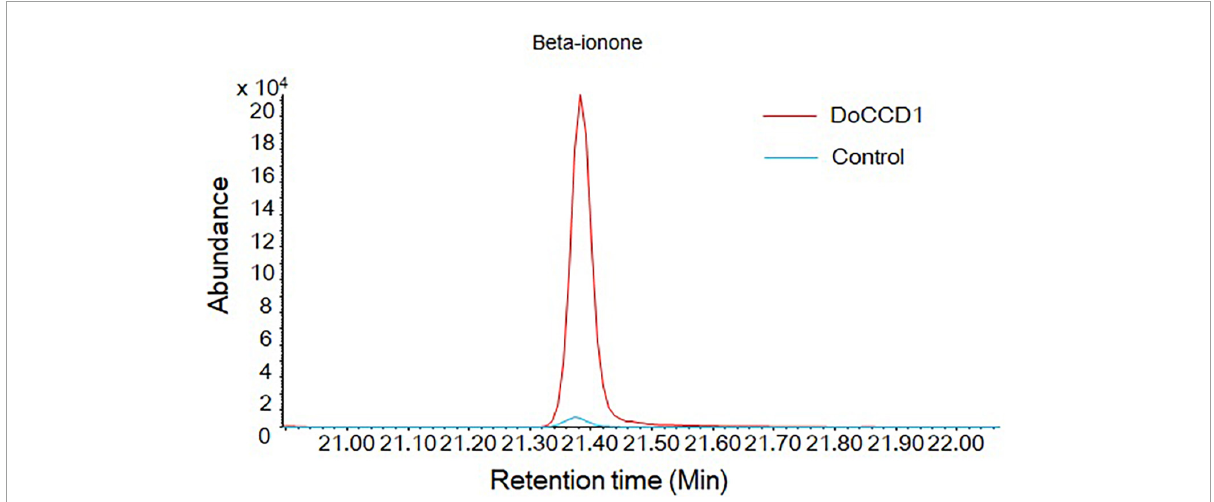
FIGURE7 Products in N. benthamiana leaves with expression of DoCCD1 by headspace SPME-GC/MS. The peak was identified as beta-ionone. The red line stands for N. benthamiana leaves with expression of DoCCD1 gene. The blue line stands for control leaves without DoCCD1